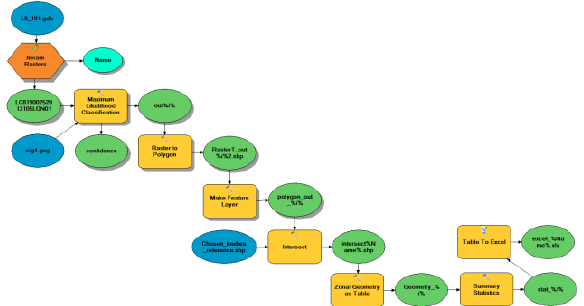
Figure 2. Model in ArcGis ModelBuilder to determinate percentage of clear water